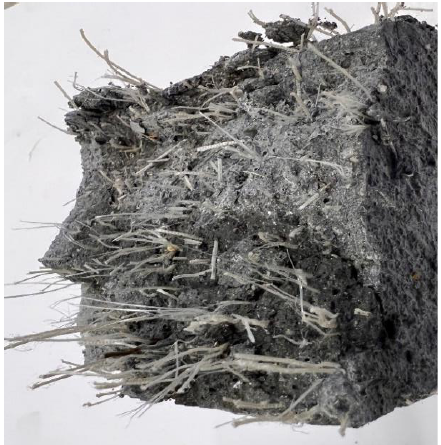
Figure 8. Crack surface in broken sample CPPfD with Durus PP fibers. Long fiber tails are not pulled out of the concrete, but mainly lifted up. Such fibers were oriented under small angles to the crack surface.